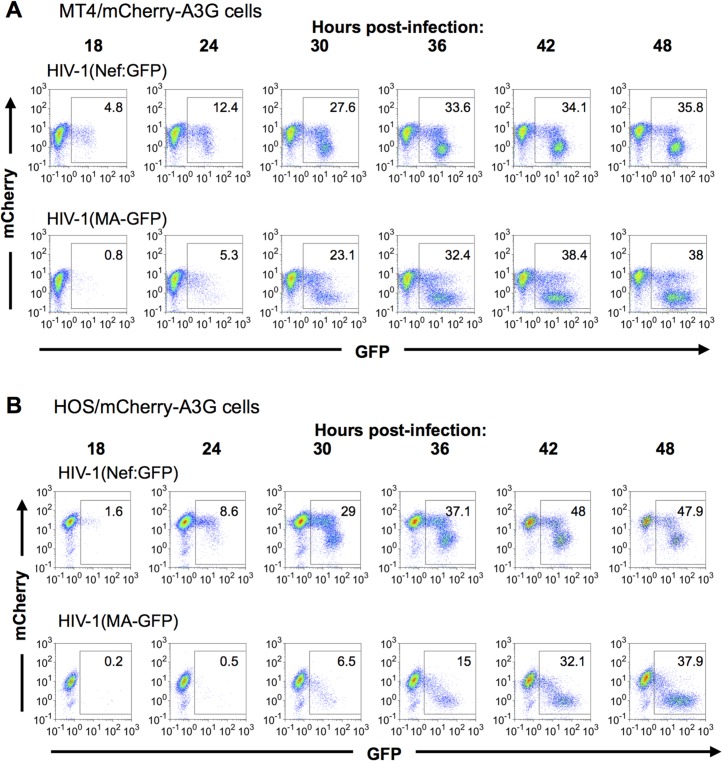
Dynamics of A3G down-regulation in populations of HIV-1 infected cells.(A, B) MT-4 cells (A) or HOS cells (B) stably expressing an mCherry-A3G fusion protein were infected with HIV-1(Nef:GFP) (upper rows) or HIV-1(MA-GFP) (lower rows). Cells were collected and fixed at the indicated time points, and levels of GFP and mCherry fluorescence analyzed by flow cytometry.